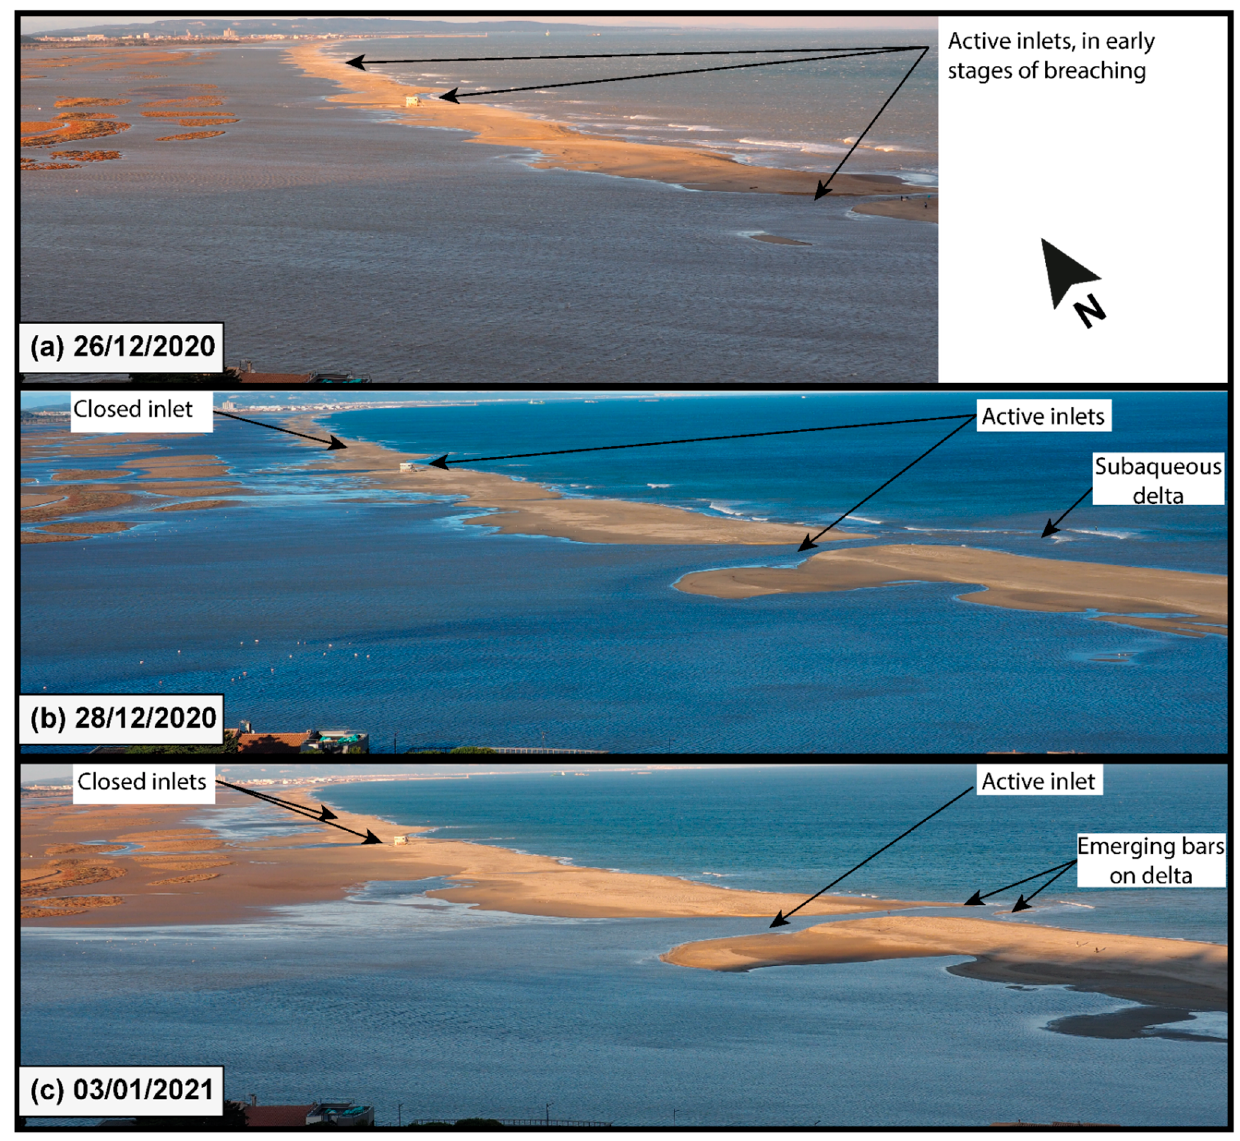
Figure 9. Photographs illustrating evolution in the development of inlets. ( a ) three active inlets at the time of opening; ( b ) a first inlet dries up in the north, the southernmost one is the widest and seems to be the deepest; ( c ) only the southernmost inlet remains, the others are filled in and dried up.